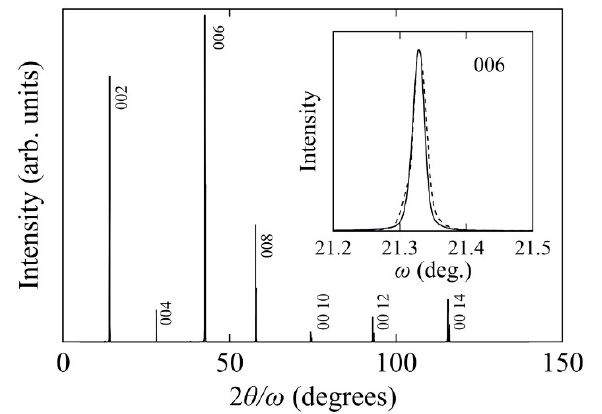
Figure 6. 2 θ / ω scanned XRD pattern of the cleaved surface of Sr 2 RuO 4 grown using the new filament. The inset shows the (006) rocking curves for the crystals grown by the new filament (full curve) and the conventional filament (dashed curve).